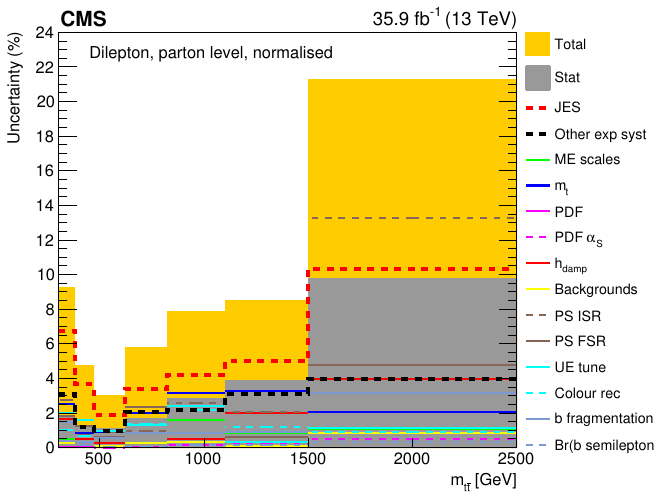
Figure 32 . The contributions of each source of systematic uncertainty to the total systematic uncertainty in each bin is shown for the measurement of the normalised tt production cross sections as a function of m . The sources a(cid:11)ecting the JES are added in quadrature and shown as a single tt component. Additional experimental systematic uncertainties are also added in quadrature and shown as a single component. Contributions from theoretical uncertainties are shown